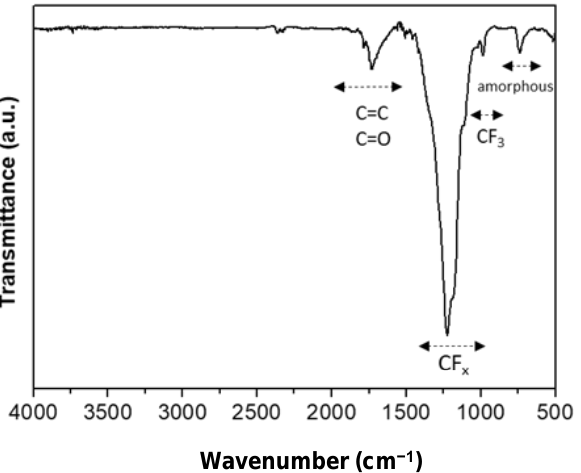
Figure 1. FT-IR spectrum of the fluorocarbon coating plasma-deposited on a silicon substrate.